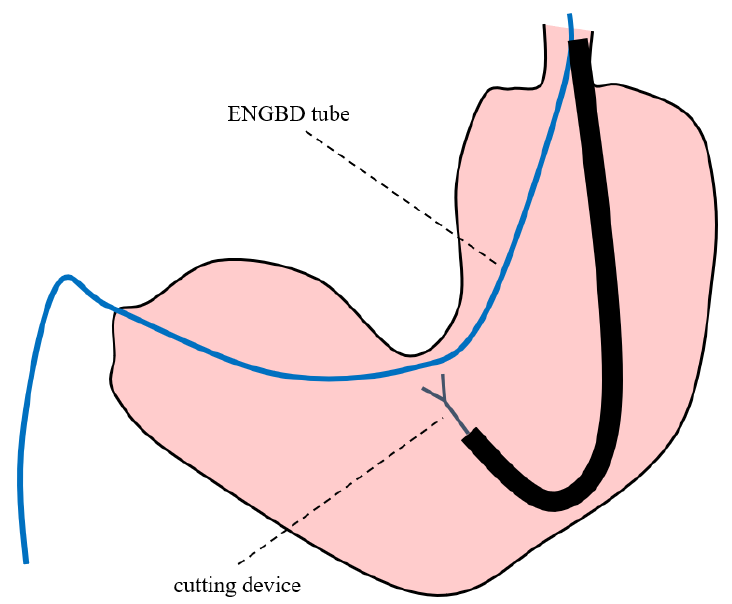
Figure 4. Endoscopic nasogallbladder drainage tube was cut by loop cutter and surgical scissors at the angle of the stomach.